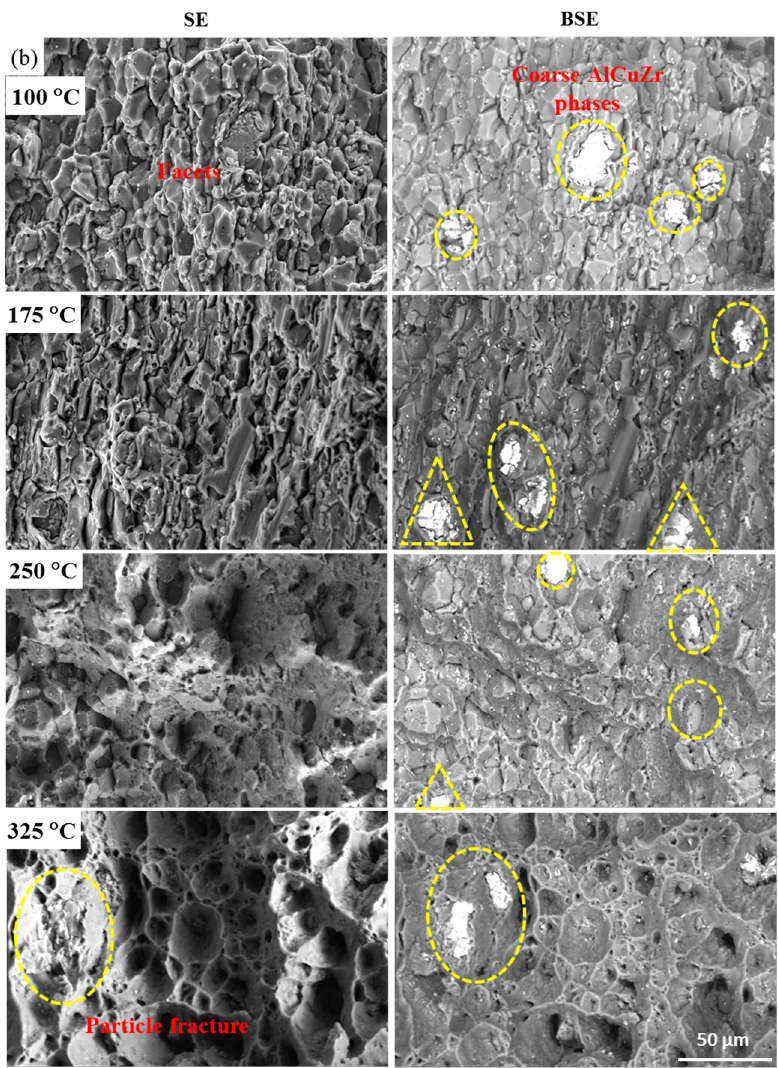
Figure 10. Fracture morphology of ( a ) Ce-containing and ( b ) Ce-free alloys after high-temperature tensile at 100 °C, 175 °C, 250 °C, and 325 °C.